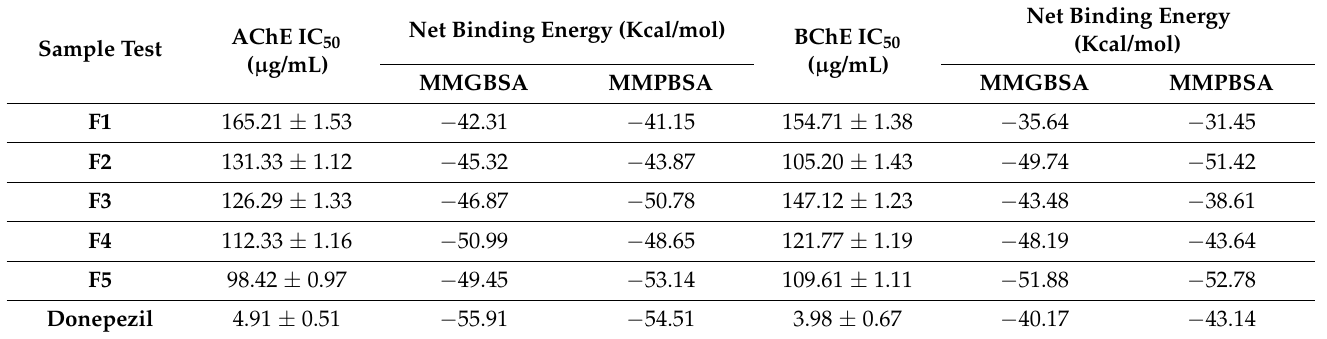
Table 2. Cholinesterase (AChE and BuChE) inhibitory activities of flavones.